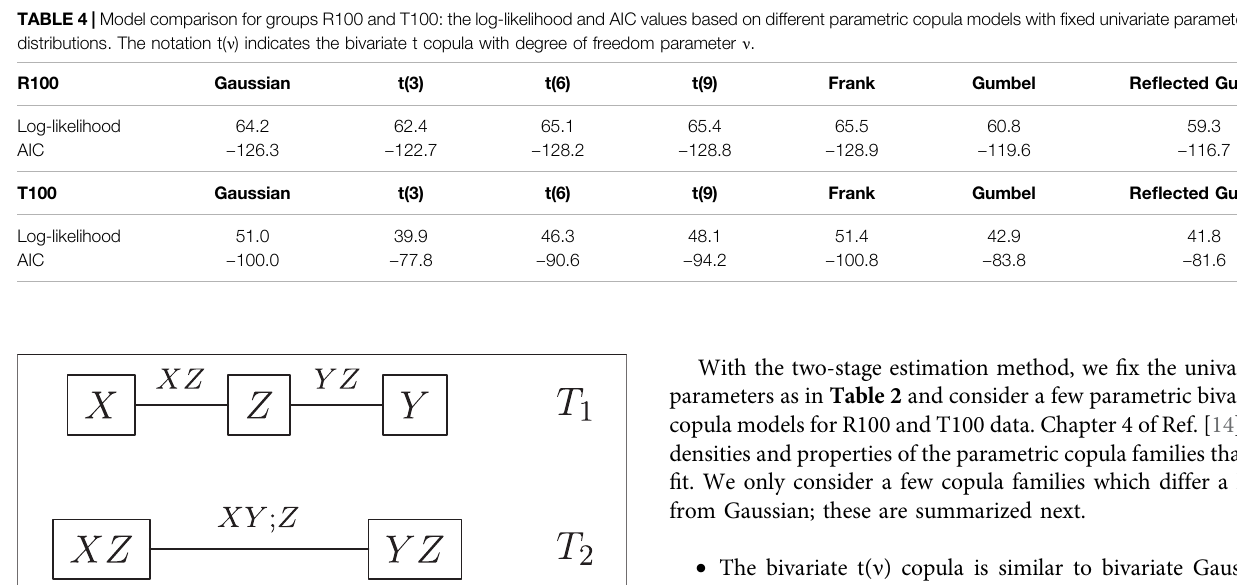
FIGURE 3 | A vine structure on three variables with two trees: X (cid:2) MOR , Y (cid:2) UTS , and Z (cid:2) MOE .